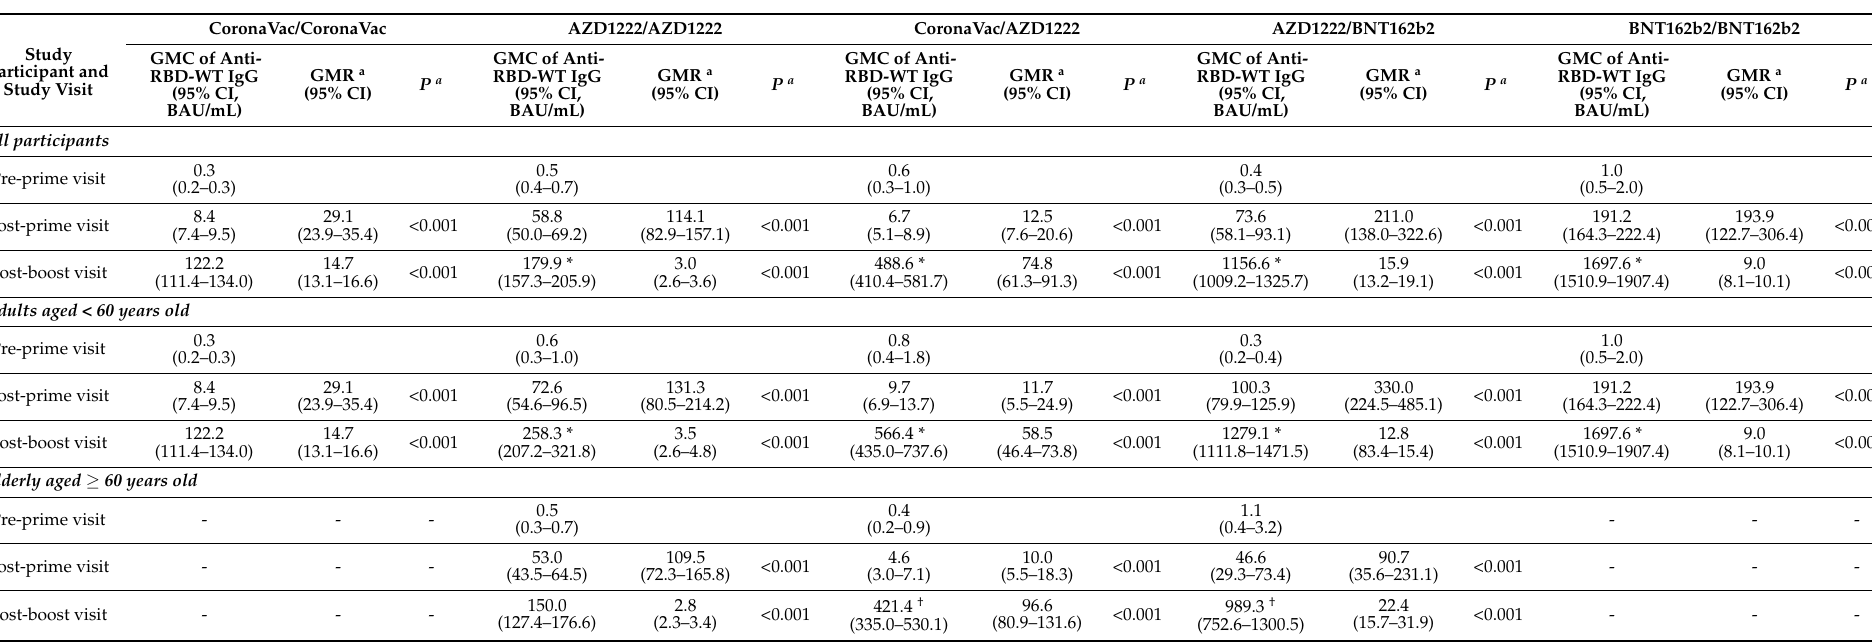
Table 2. The geometric mean concentrations of anti-SARS-CoV-2 receptor-binding domain immunoglobulin G against wild-type SARS-CoV-2 following a primary series of COVID-19 vaccination, stratified by the COVID-19 vaccine